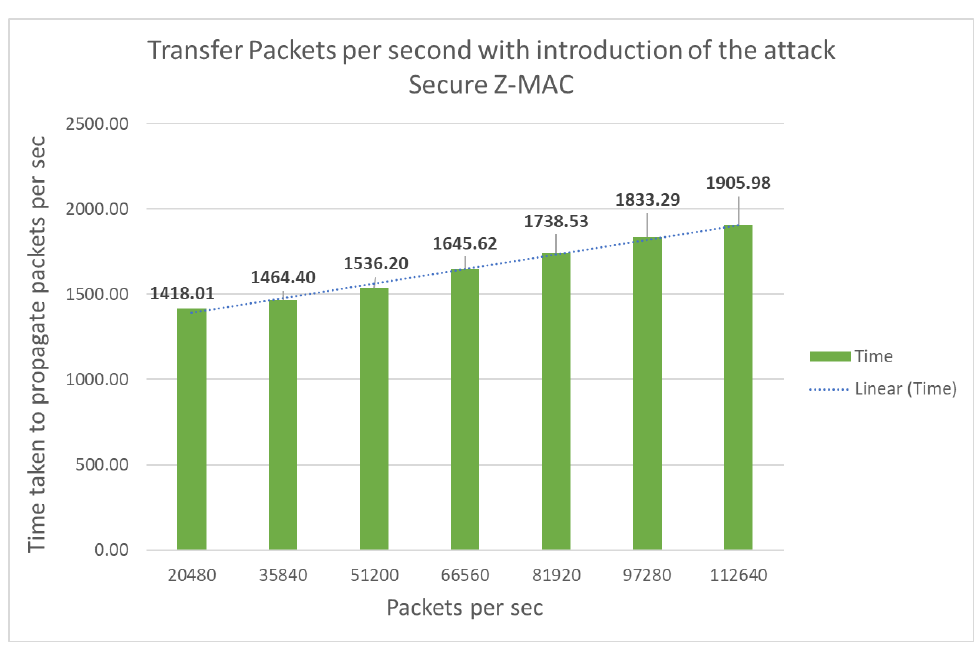
Figure 10. Total transmission time for nodes using the secure Z-MAC scheme.